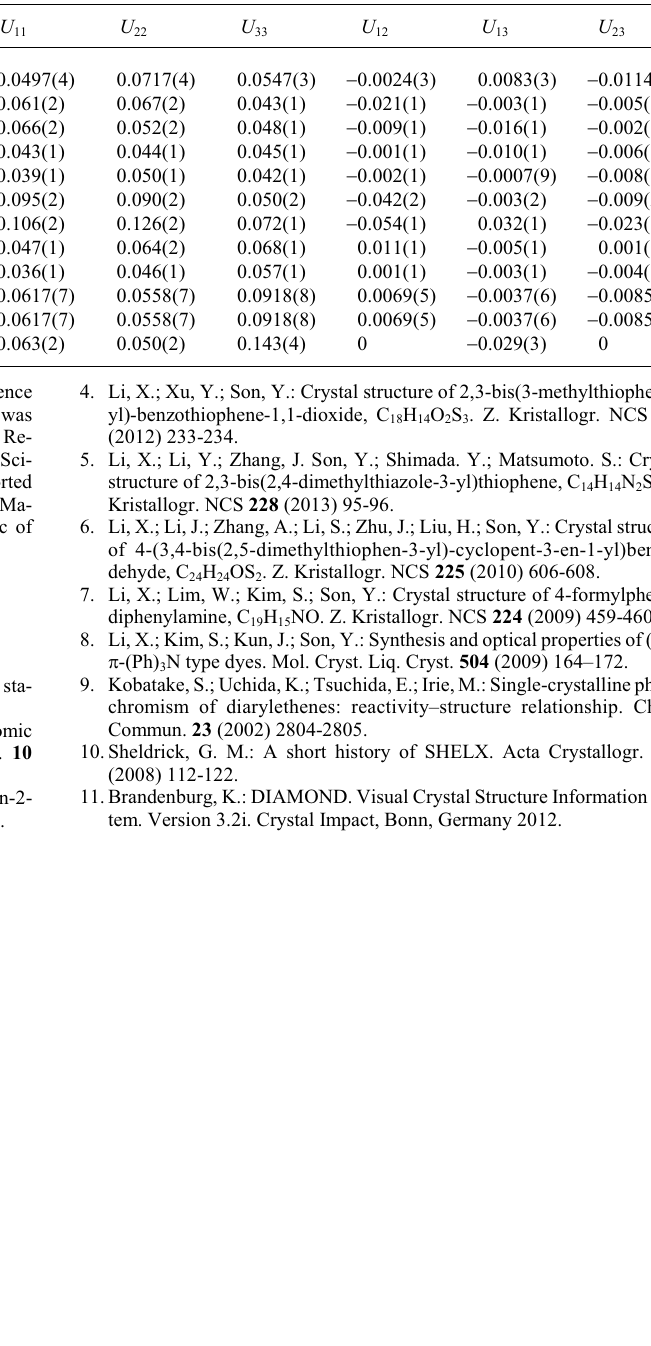
Table 3. Atomic coordinates and displacement parameters (in Å 2 )